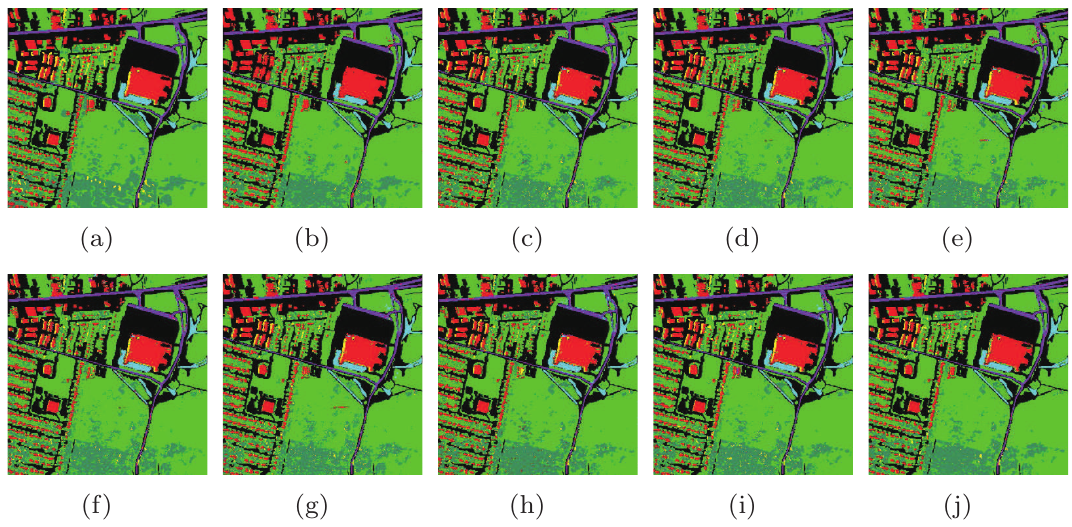
Figure 16. Classification maps of different methods with SVMCK on the Urban data set. ( a ) Ground truth; ( b ) Baseline (86.0%, 0.765); ( c ) PCA (85.1%, 0.750); ( d ) NPE (86.5%, 0.773); ( e ) LPP (87.0%, 0.781); ( f ) SDE (85.7%, 0.758); ( g ) LFDA (85.6%, 0.759); ( h ) MMC (86.1%, 0.765); ( i ) MFA (87.5%, 0.788);